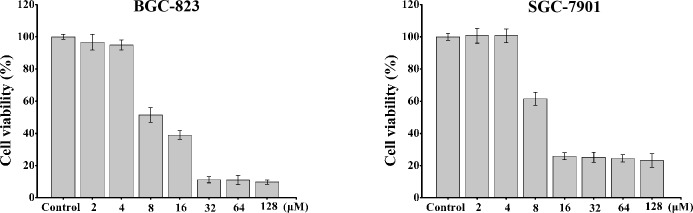
HPRP-A2-induced BGC-823 and SGC-7901 cell death.The cells were treated with different concentrations of HPRP-A2 for 1 hour. Cell viability was determined using the MTT method. Results are expressed as percentage of the control ± SD of three independent experiments. Statistical analysis compared the HPRP-A2 treatment group with the control groups (*P < 0.005; **P <0.001).